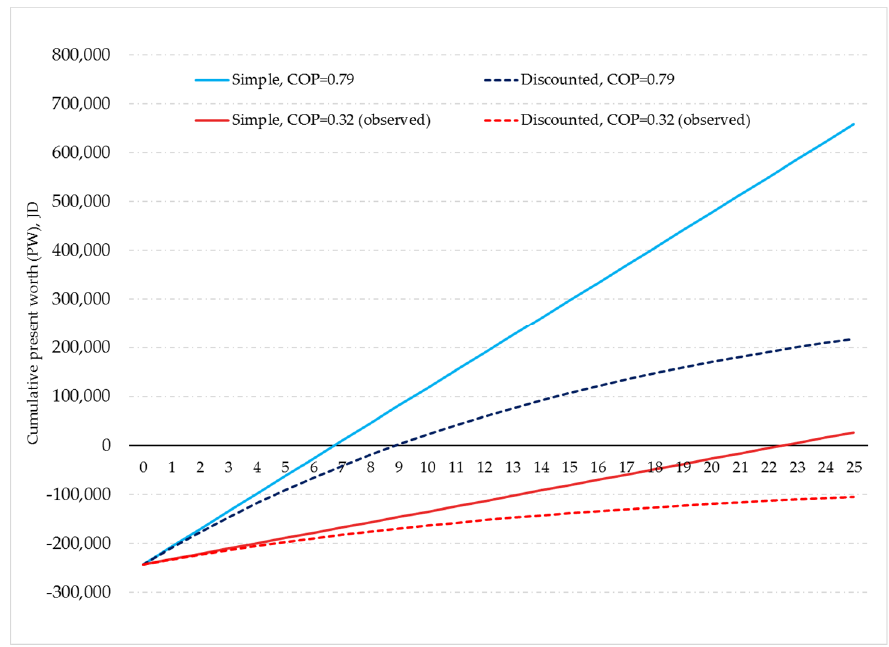
Figure 12. Simple (solid lines) and discounted (dashed lines) payback periods for the claimed COP = 0.79 (blue lines) and the observed COP = 0.32.